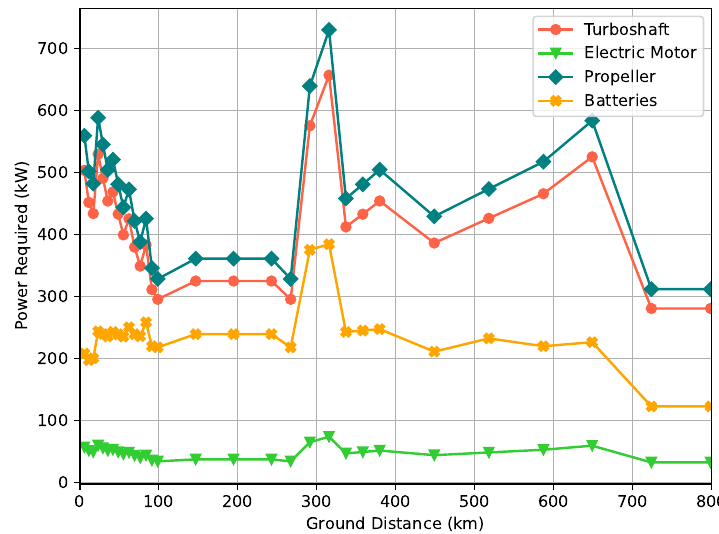
Figure 11. Power required to the parallel hybrid propulsive